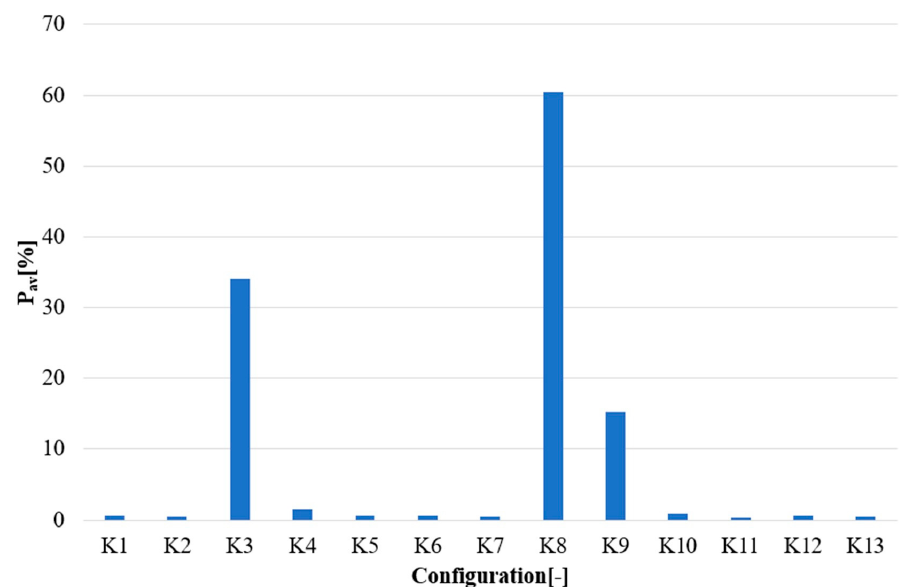
Figure 9. Average values of the number of data packets lost for each of the tested configurations.